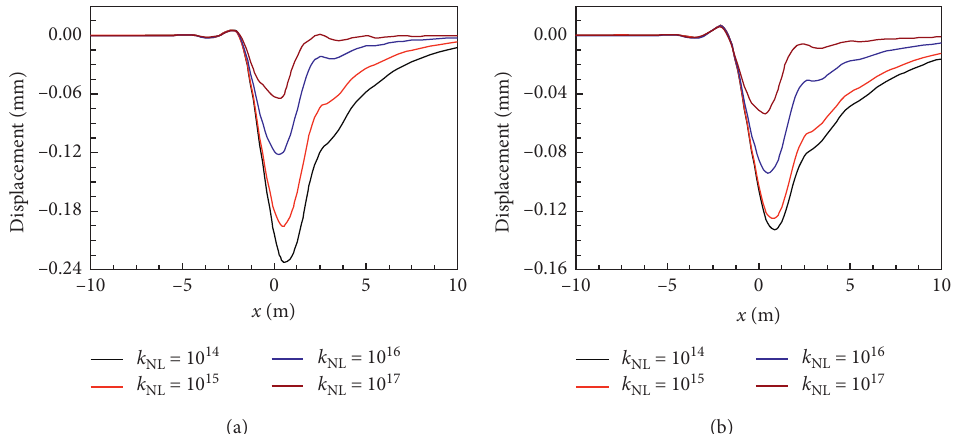
Figure 8: The effect of nonlinear stiffness on the history of vertical displacement at the middle of the track corresponding with location of the moving vehicle: (a) v � 50 and (b) v � 75 m/s.